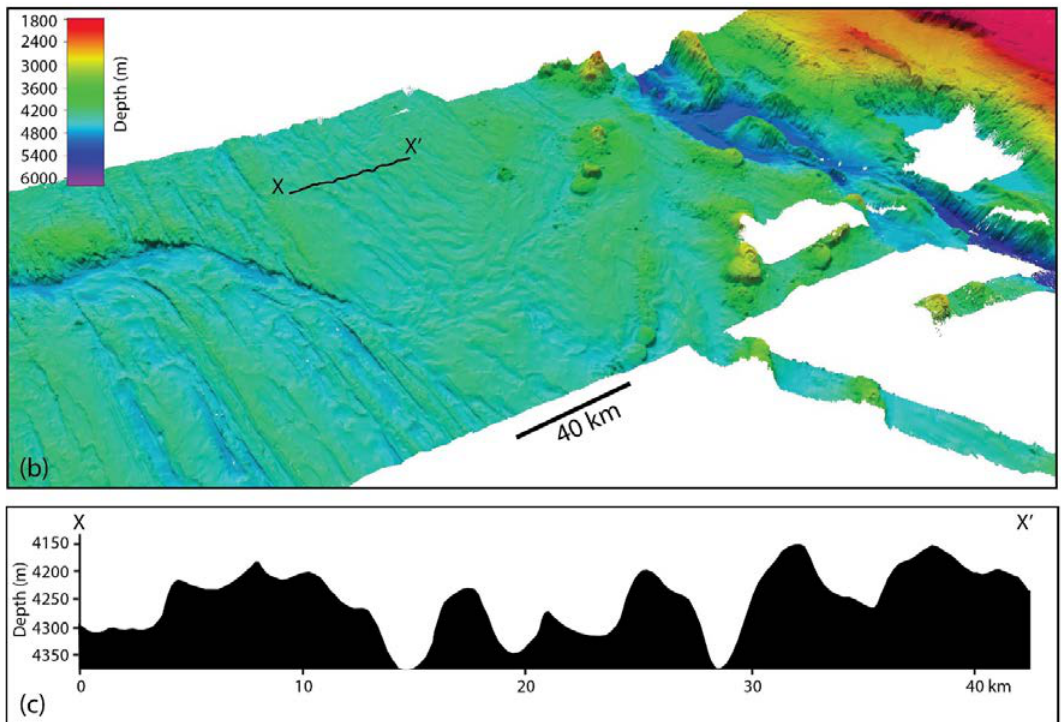
Figure 9. ( a ) Surface ship multibeam sonar data collected (~710,000 km 2 ) in support of the search for wreckage of Malaysian Airlines Flight MH370. ( b ) close-up revealing bathymetric detail provided by multibeam sonar including tectonic fabric and deep-sea trench (see [27] for details) VE = 6×) ( c ) cross-section of small area (black line in ( b ) demonstrating roughness of topography and why surficial mapping was necessary before deploying near-bottom mapping systems (AUVs or ROVs).